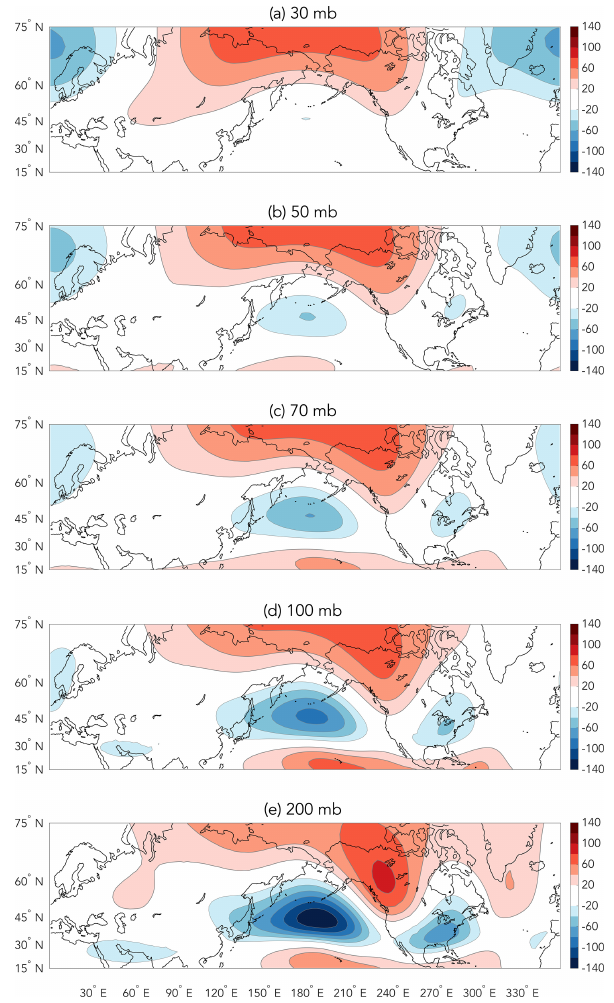
Figure 5. February–March El Niño geopotential height (units: gpm) anomaly composites between 30–200mbar ( a to e